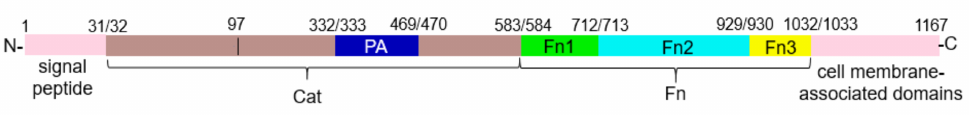
Figure 1. Schematic representation of the domain organization of ScpA. Cat domain is salmon, PA domain is blue, three Fn domains are green, cyan, and yellow, respectively, and the signal peptide and cell membrane-associated domains are pink. Numbers indicate domain boundaries in